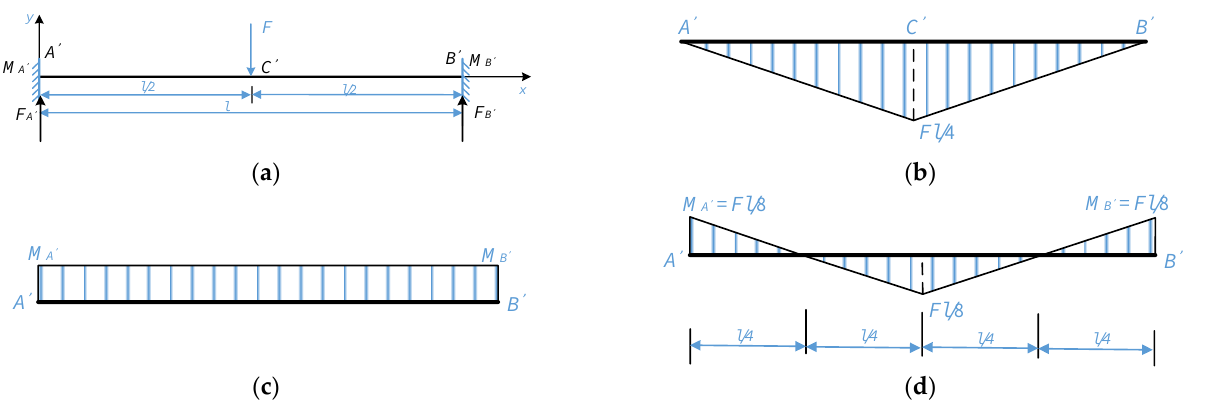
Figure 6. Schematic diagram of fixed beam and bending moment diagrams: ( a ) the fixed beam; ( b ) the free bending moment diagram; ( c ) the fixed-end moment diagram; and ( d ) the resultant bending moment diagram.